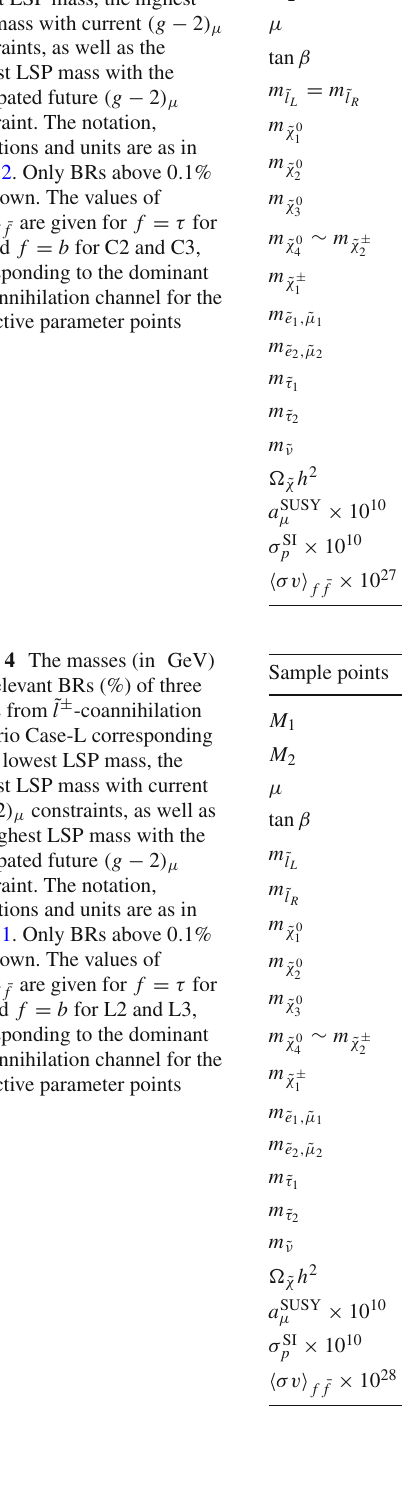
Table 3 The masses (in GeV) Sample points and relevant BRs (%) of three points from ˜ χ ± -coannihilation 1 scenario corresponding to the lowest LSP mass, the highest LSP mass with current ( g − 2 ) μ constraints, as well as the highest LSP mass with the anticipated future ( g − 2 ) μ constraint. The notation, definitions and units are as in Table 2. Only BRs above 0 . 1% are shown. The values of (cid:7) σv (cid:8) are given for f = τ for f ¯ f C1 and f = b for C2 and C3, corresponding to the dominant DM annihilation channel for the respective parameter points